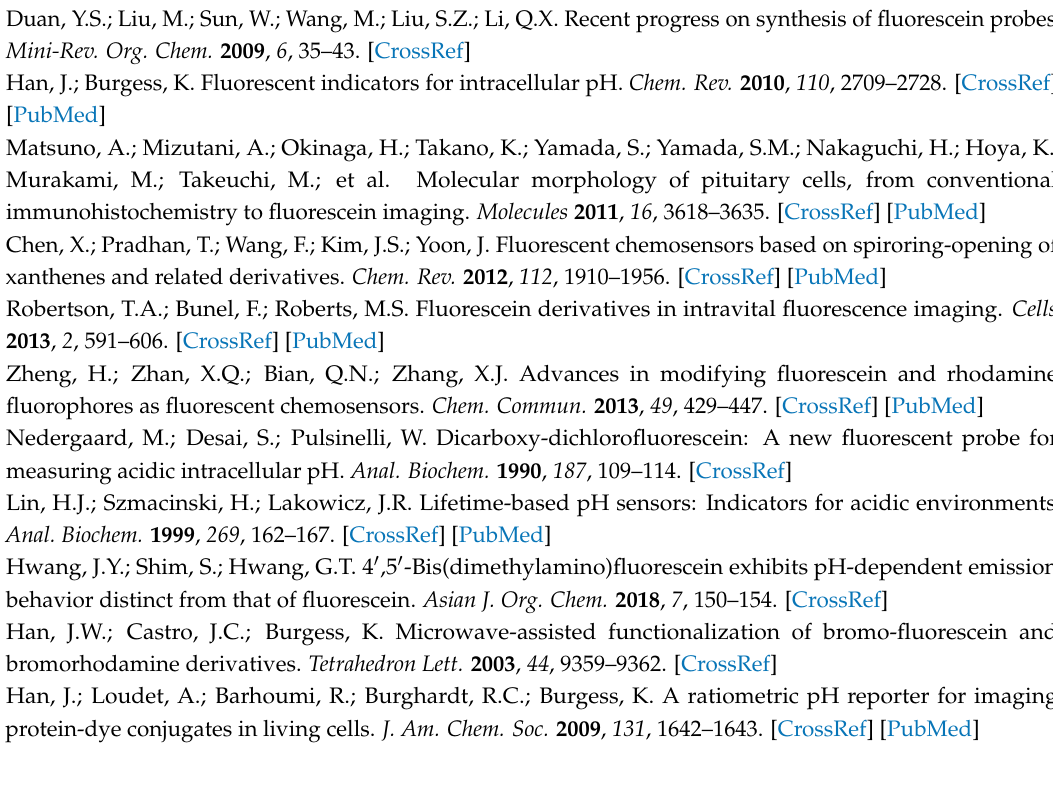
photophysical properties, Figure S2: emission spectra, Figure S3: fluorescence decay profiles, Figure S4: absorption and emission spectra in HCl solution, Figures S5–S8: spectra of 2 and 3 , Figures S9–S18: 1 H NMR and HRMS